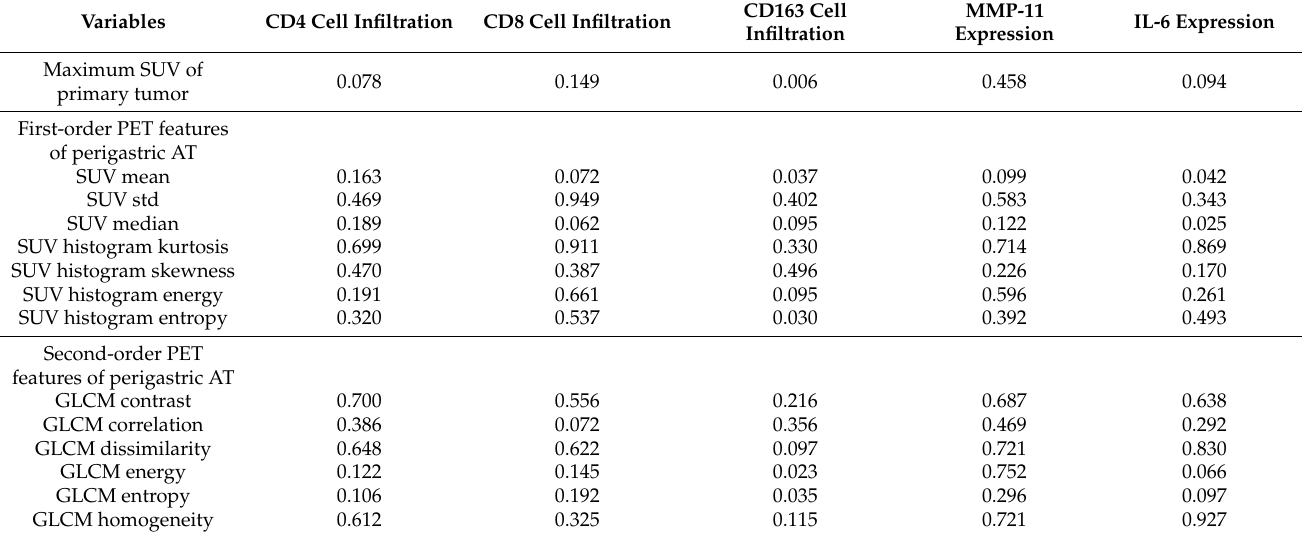
Table 2. Statistical significance of the Kruskal − Wallis test for comparing the maximum SUV of primary tumor and perigastric AT imaging features according to the histopathological results of perigastric